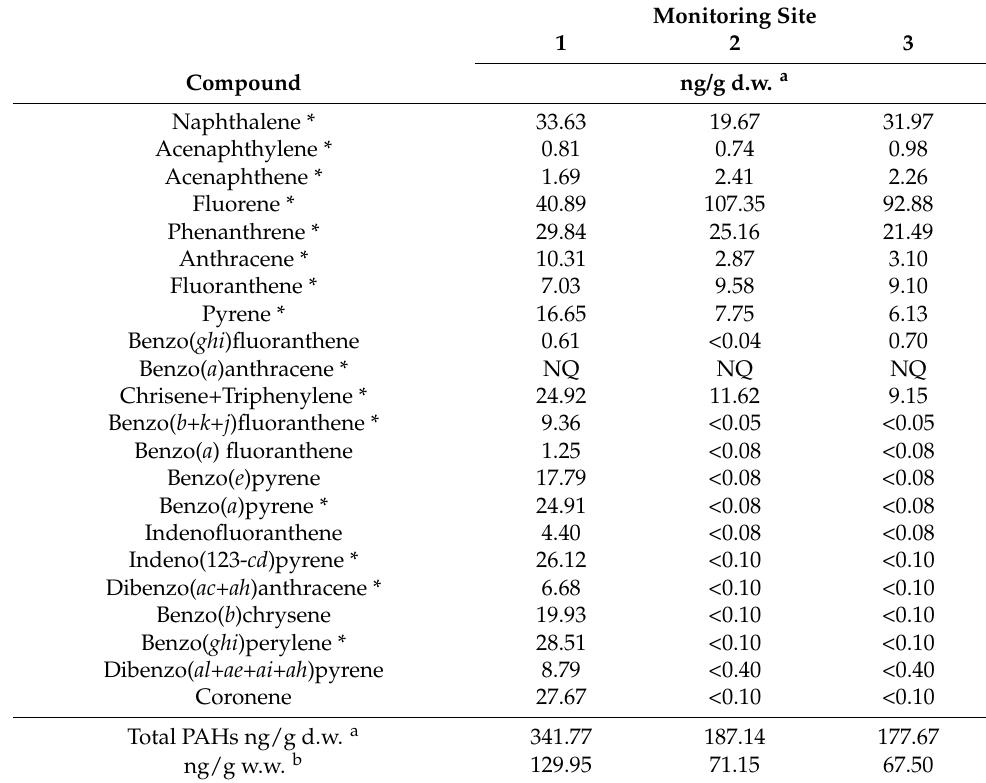
Table 4. PAH concentrations (expressed as ng/g honeybee d.w.) of three monitoring bee